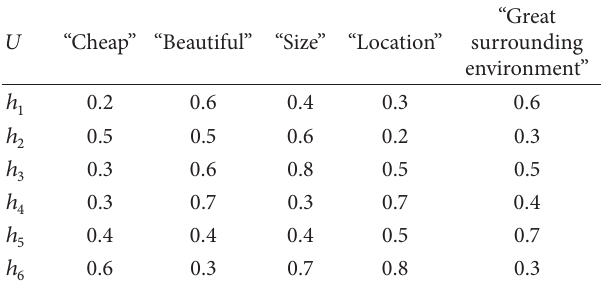
Table 2: The tabular representation of the fuzzy soft set 𝑈 “Cheap” “Beautiful” “Size” “Location”